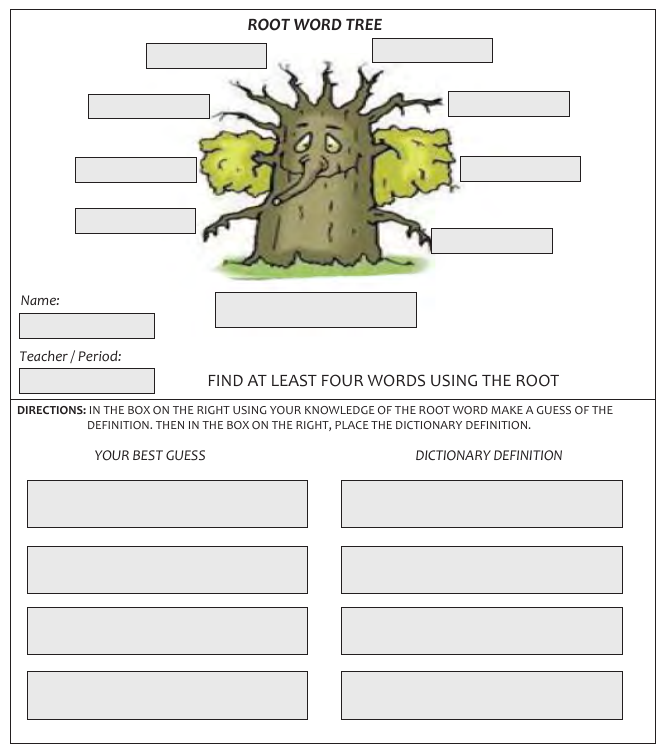
Figure 2: The Root Word Tree (McKnight,